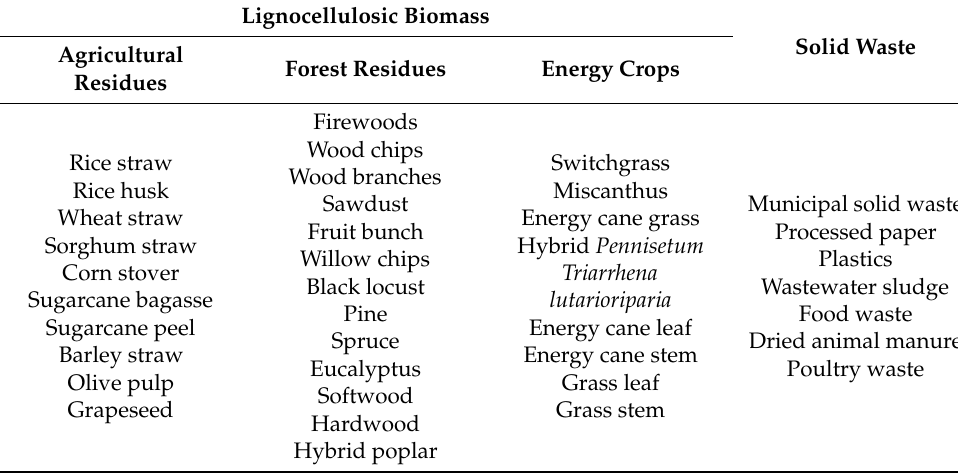
Table 1. Categories and examples of solid biofuel